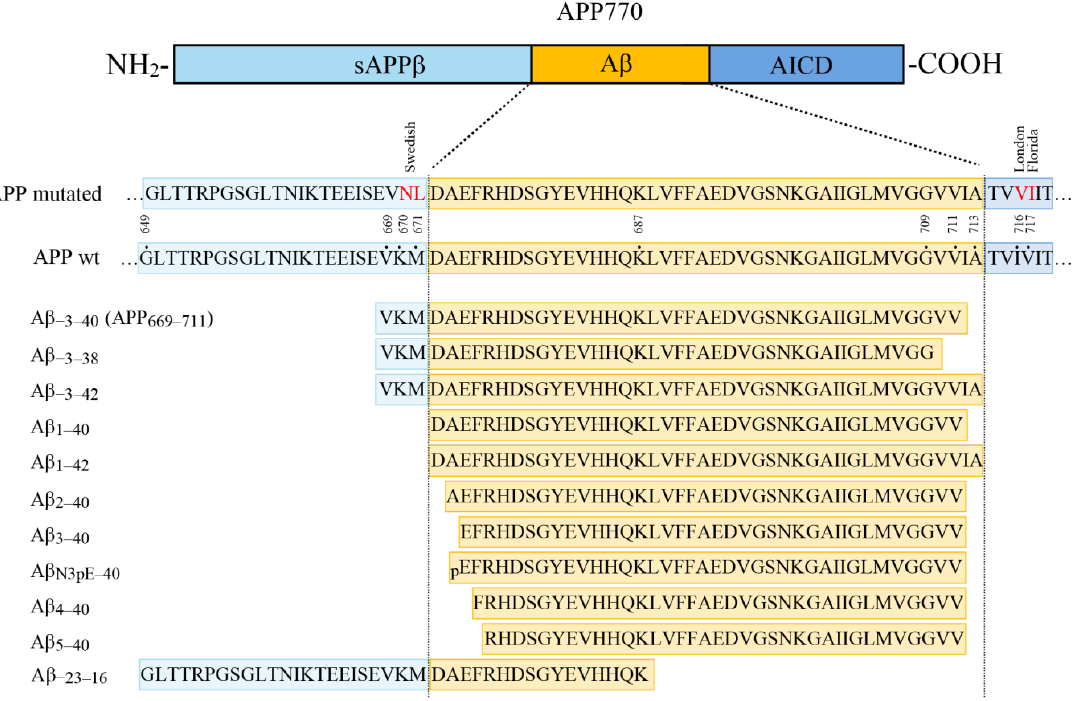
Figure 1. Amino acid sequences and numbering of the Aβ variants and amyloid precursor protein (APP)-related peptides that were studied. On top, a schematic diagram of the primary structure of the human APP770 isoform is shown. The Aβ peptide region, sAPPβ, and the APP intracellular domain (AICD) are indicated by different colours. Partial amino acid sequences of wild type APP770 and a mutant APP are shown in the middle panel. The positions of the Swedish (K670N/M671L) double mutation as well as the I716V (London) and V717I (Florida) mutations are highlighted in red colour. In the lower panel, the amino acid sequences and nomenclature of the 11 different synthetic peptides employed in this study are summmarized.